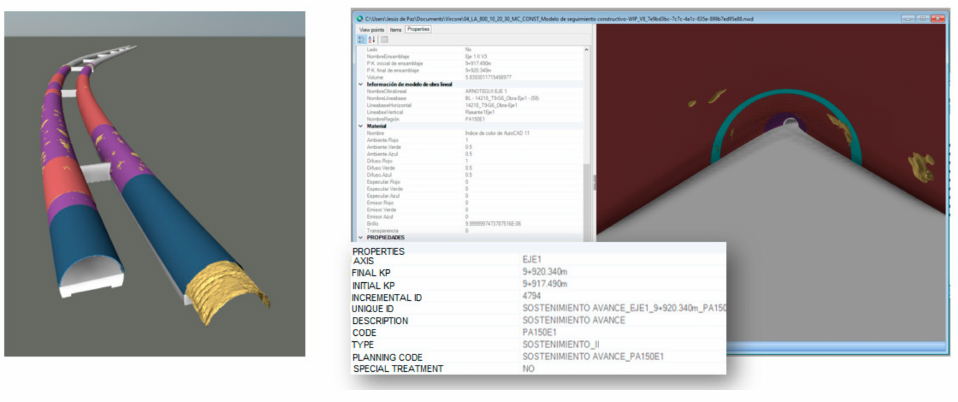
Figure 6. Follow-up